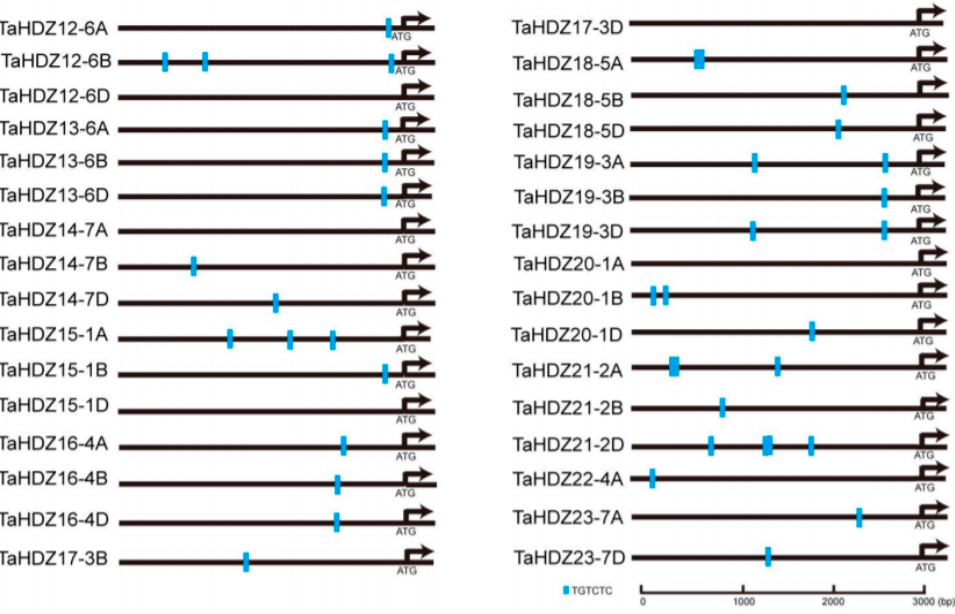
Figure 8. The “TGTCTC” elements in the 3 Kb genomic regions upstream of coding regions are indicated by blue box.